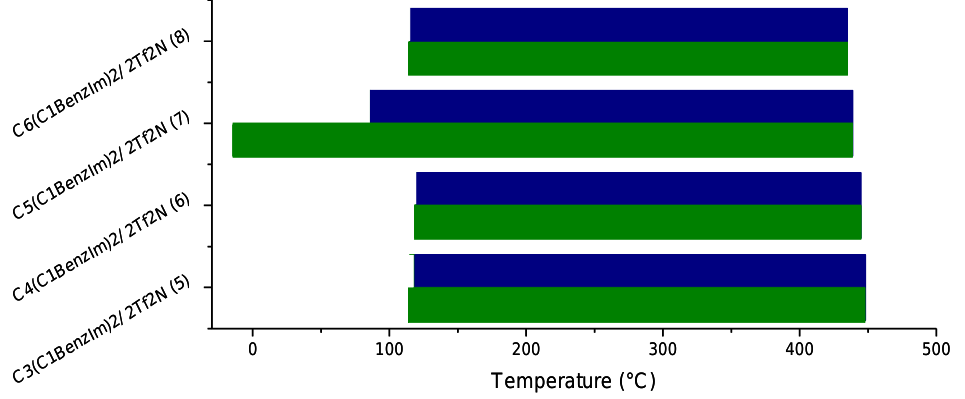
Figure 4. Operative range of Tf 2 N BDILs: the blue bars and green bars were obtained by using a minimum value of the temperature of the transition of the first heating run and the second heating run of DSC analyses, respectively. As the maximum value of temperature, T onset of the main degradation obtained by TGA analyses was taken in both